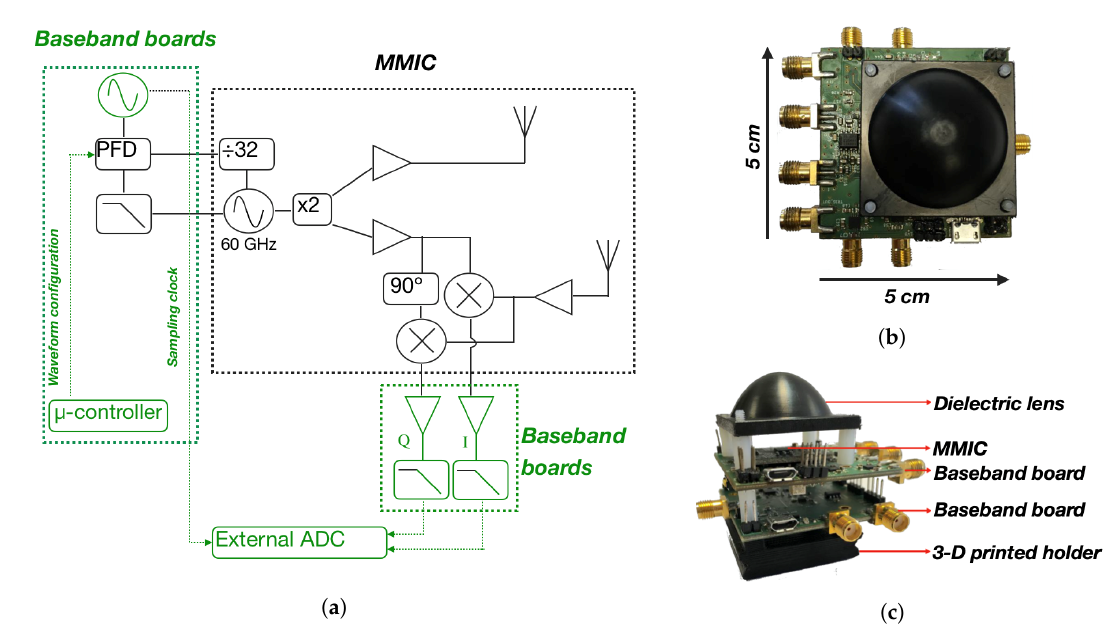
Figure 4. ( a ) Diagram of the radar’s RF and baseband architecture. Items in green have been modified from the original commercial version. ( b ) Photograph of the sensor: top view. The connectors on the sides of the sensor are various I/Q, clock and trigger outputs. The microcontroller includes a USB connector to receive waveform configuration orders from a PC. ( c ) Photograph of the sensor: front